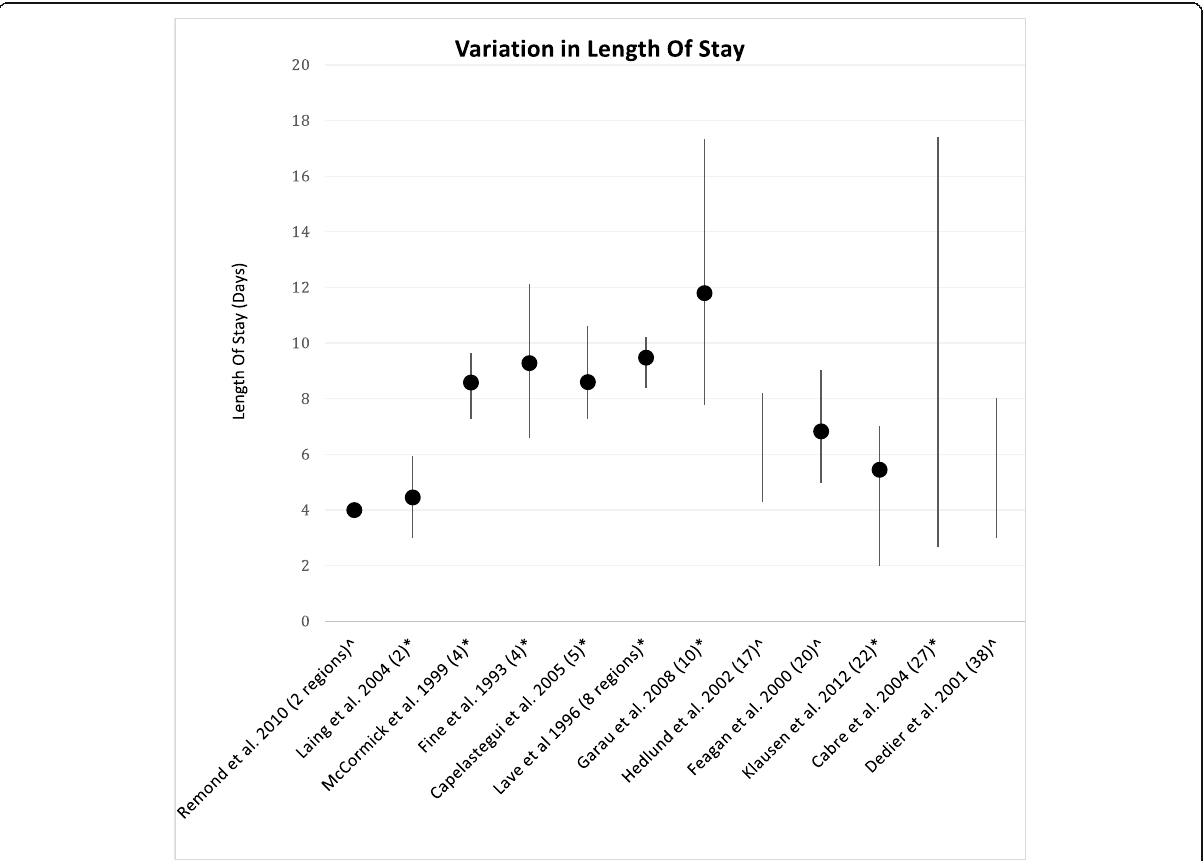
Fig. 2 Inter-hospital variation in average LOS in days across studies where reported. Range represented as line, dot represents mean value where possible. * denotes a statistically significant result. ^ denotes no reported p value. The number in brackets represents the number of hospitals compared in the study, unless otherwise